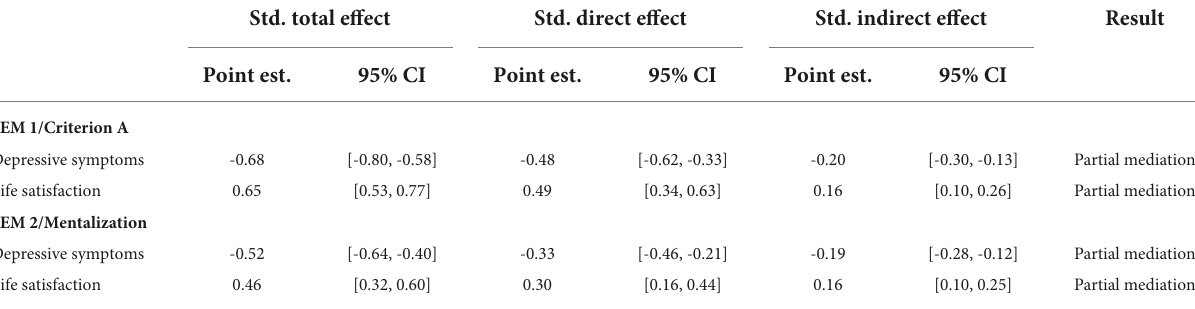
TABLE 4 Total, direct and indirect effects of SEM1 (Criterion A) and SEM2 (mentalization) on depressive symptoms and life satisfaction with resilience as